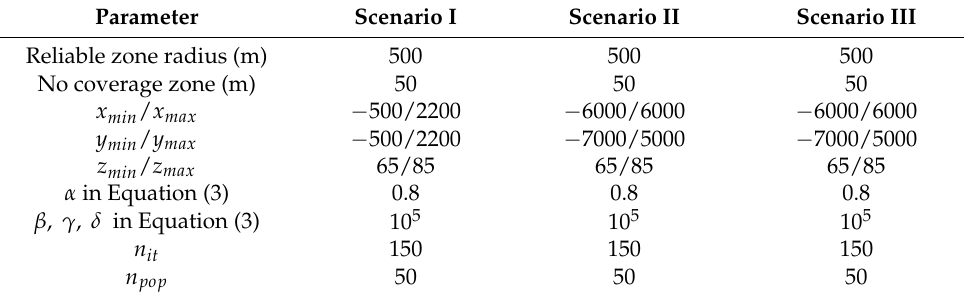
Table 3. General and PSO simulation